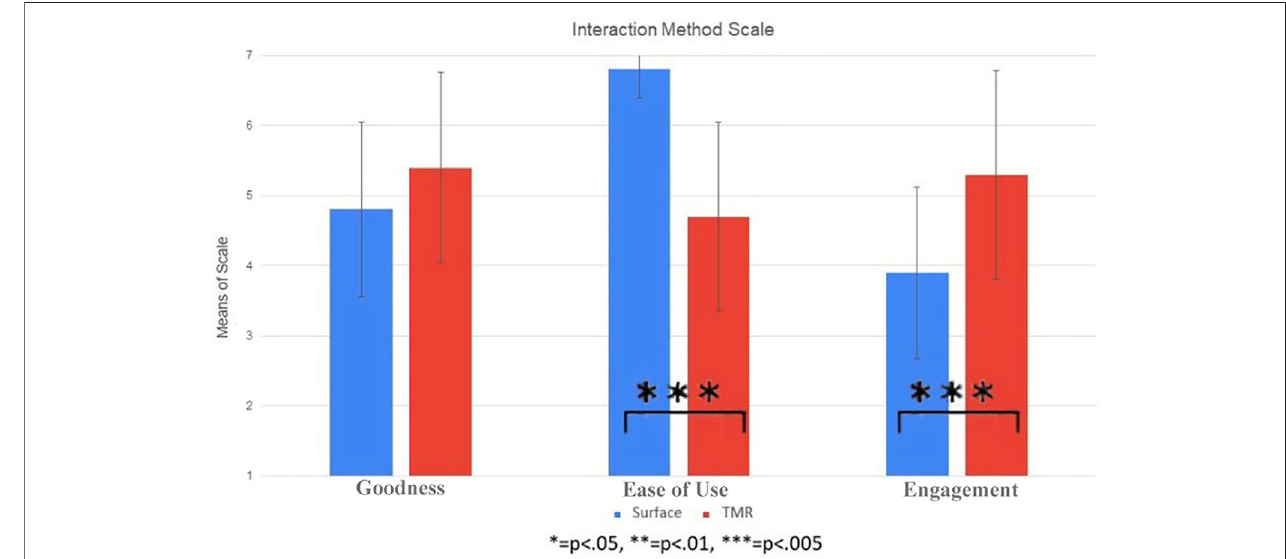
FIGURE 9 | Subjective ratings between Surface gesture and TMR motion gesture. The error bars show standard error.